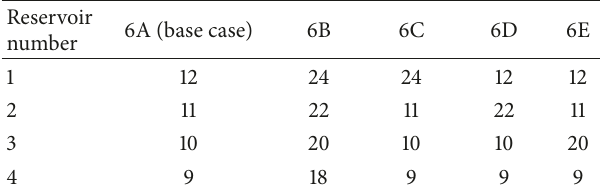
Table 6: Five cases with different reservoir thicknesses (m). Reservoir